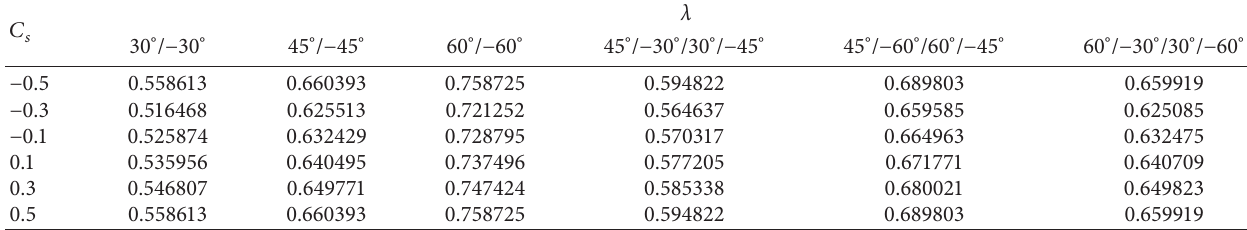
Table 7: Fundamental frequency parameter value with sinusoidal variation in thickness for different stacking sequences.